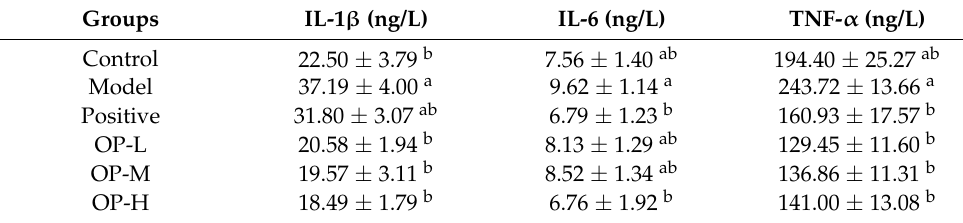
Table 2. Effect of OP on pro-inflammatory cytokines in tissues of the ALD mice.